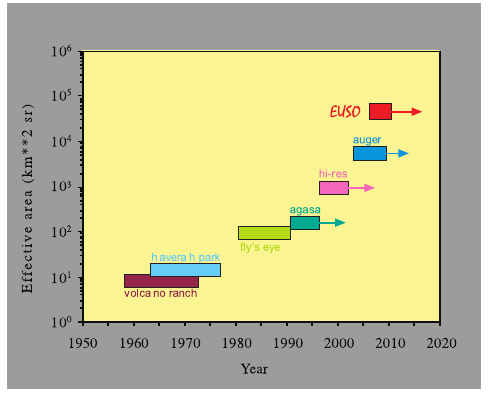
Fig. 13. A comparison of the EUSO effective area with ground based